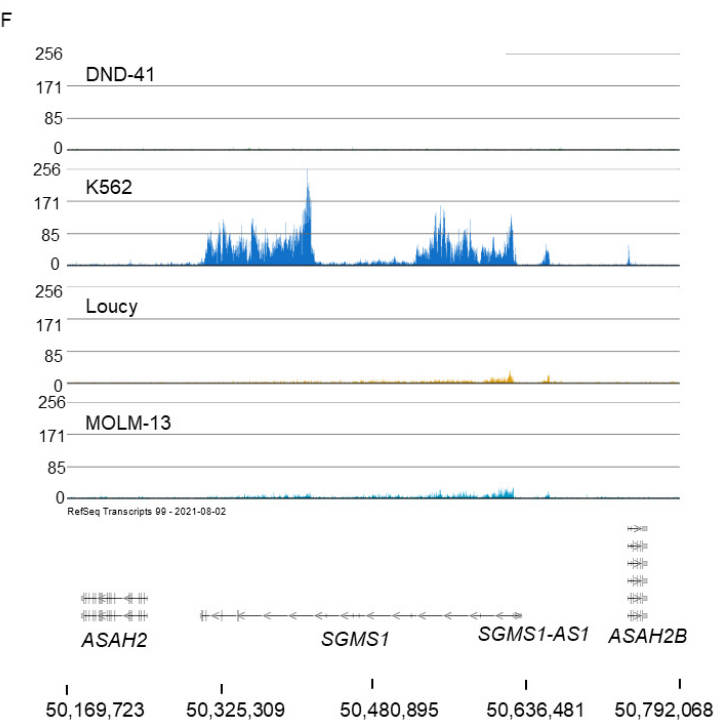
Figure 3. H3K79me2 ChIP-Seq tracks of genes with the broad H3K79me2 domain. The panel shows the H3K79me2 ChIP-Seq tracks for the four cell lines. ( A ) DACH1 , ( B ) ZNF21 , ( C ) NLGN4X , ( D ) HIVEP3 , ( E ) SPRY1 , ( F ) SGMS1 .